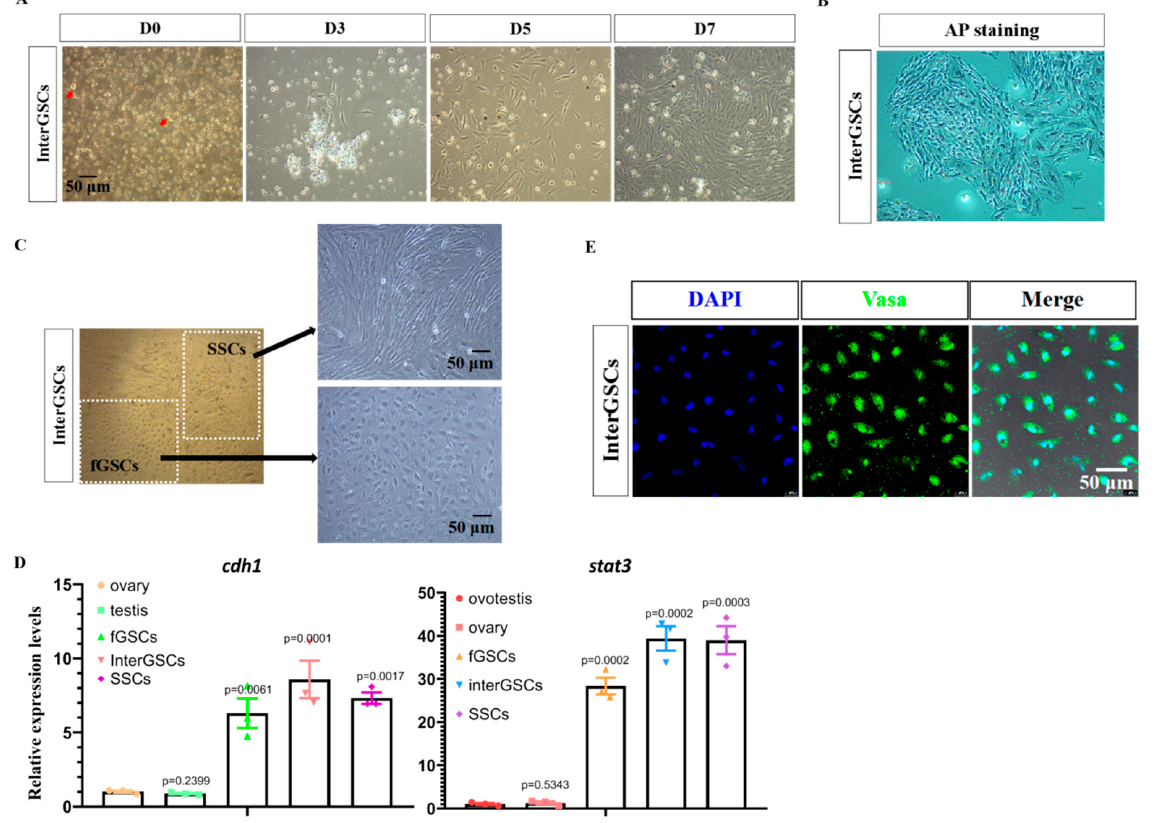
Figure 3. Isolation and characterization of interGSCs derived from ovotestis. ( A ) Cell morphology of GSCs isolated from ovotestis at the indicated time after isolation. Red arrows show the grape-like GSCs. ( B ) Image of AP staining of interGSCs isolated from ovotestis. ( C ) Cell morphology showing the presence of two morphologically distinct cell types. ( D ) qRT-PCR results of cdh1 and stat3 in fGSCs, SSCs, and interGSCs, compared with whole ovary, testis, and ovotestis tissues. ( E ) Immunofluorescence images for day 7 interGSCs.